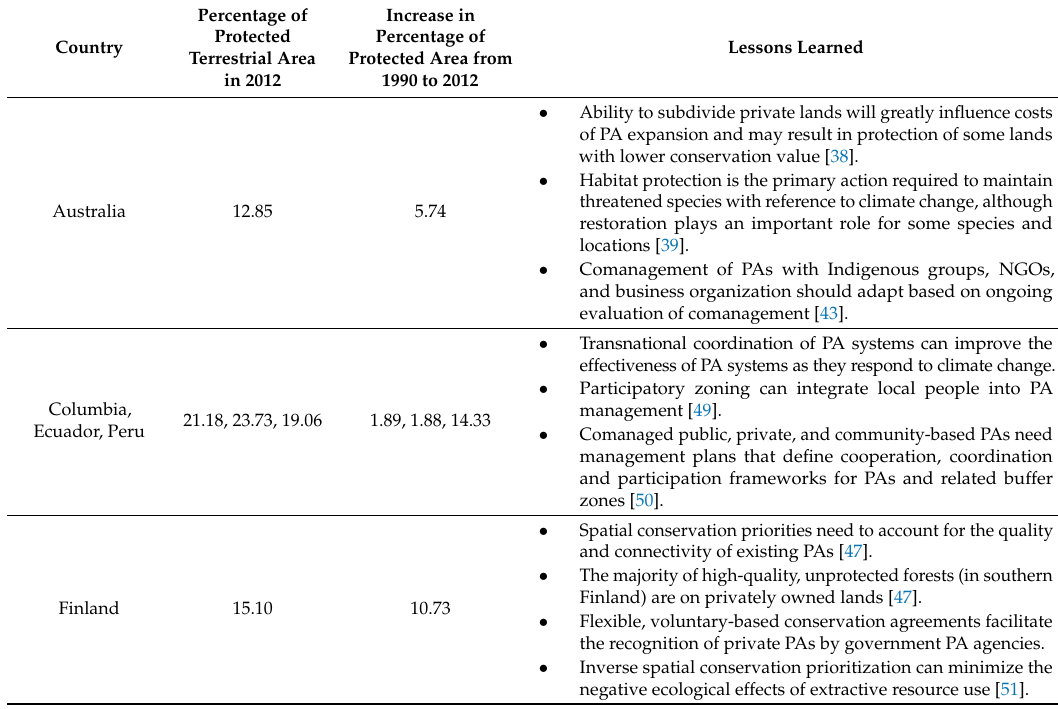
Table 6. International examples of protected area system